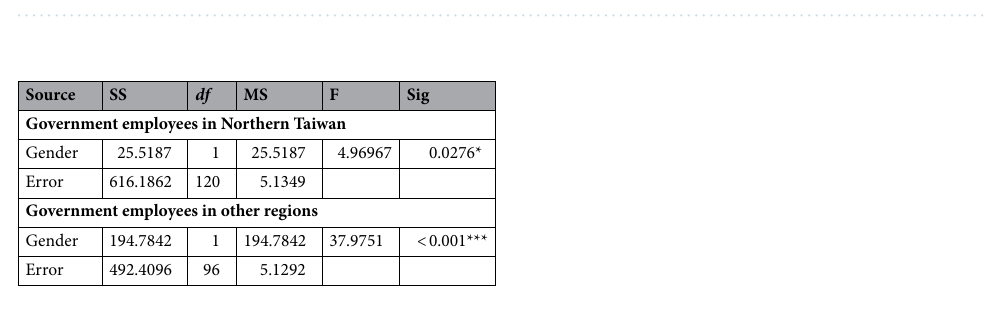
Table 10. Simple simple main effect of government employment on personal protective measures. * p < .05, *** p < .001.